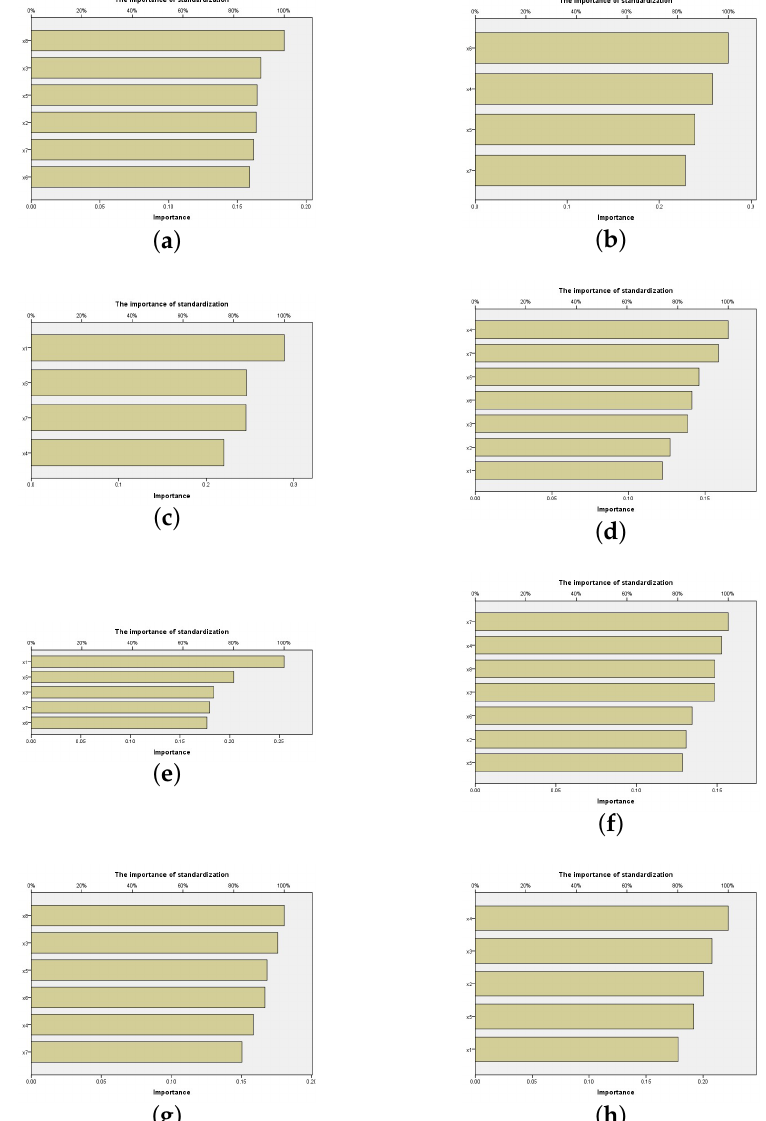
Figure 2. The importance of input variables of the BP neural network model for the G7 countries: ( a ) Canada ( b ) France ( c ) Germany ( d ) Italy ( e ) Japan ( f ) the United Kingdom ( g ) the United States ( h ) European Union.